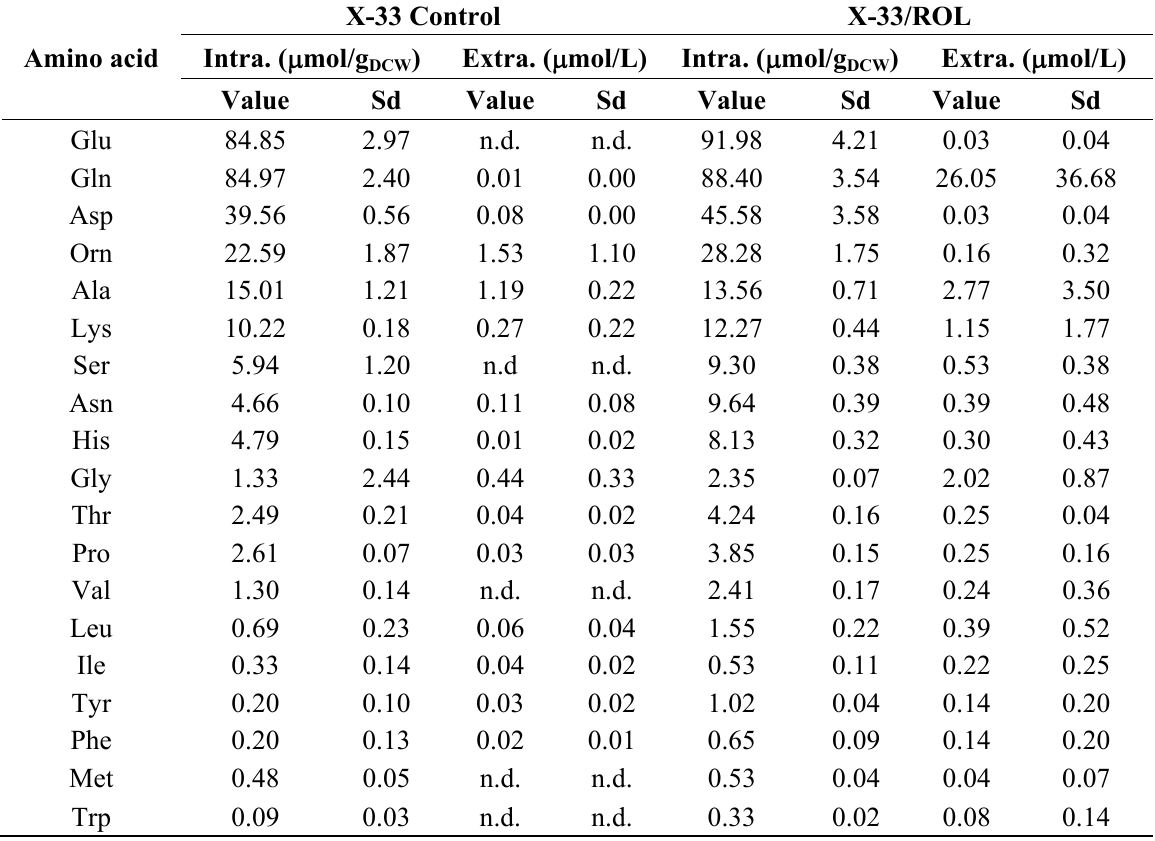
Table 4. Intra and extracellular amino acid concentrations in P. pastoris cells growing on glucose/methanol. Intracellular concentrations (Intra.) of metabolites pools are given in . Extracellular concentrations (Extra.) of metabolites are given in   mol/g CDW